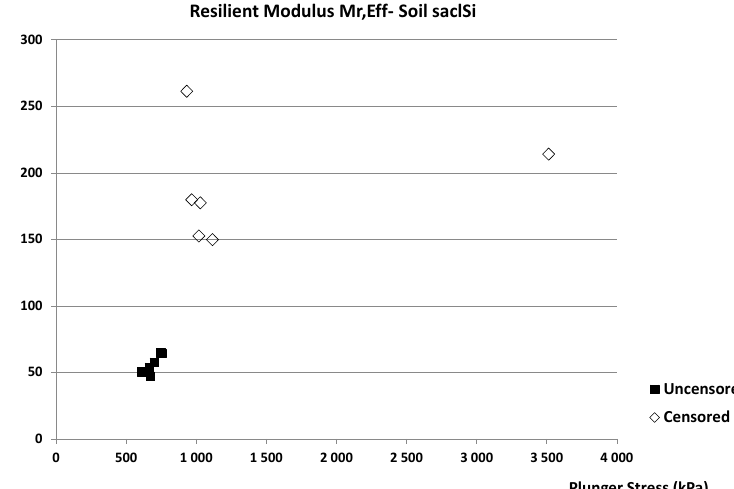
Figure 5. Resilient modulus M r,eff for soil saclSi.